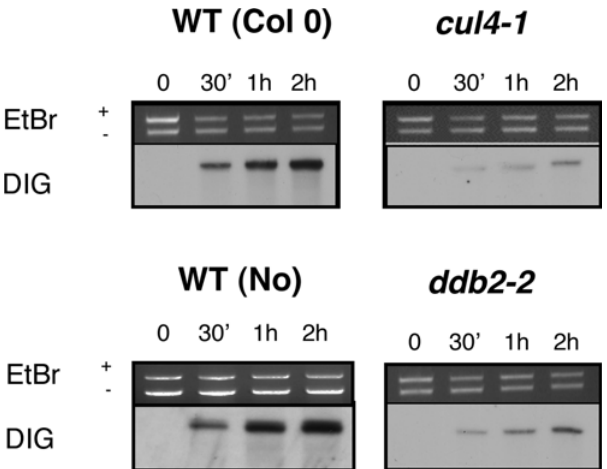
Figure 2. Invitro synthesis DNA repair assays of UV-C damaged plasmid. Cell extracts (20 m g) from WT (Col/Nossen), cul4-1 and ddb2-2 plants were incubated with UV-C damaged (UV-C treated pGEX: + UV-C) and control (untreated pBKS: 2 UV-C) plasmids in the presence of DIG- dUTP. Incorporation was evaluated during a time course. These pictures are representative of 2 independent